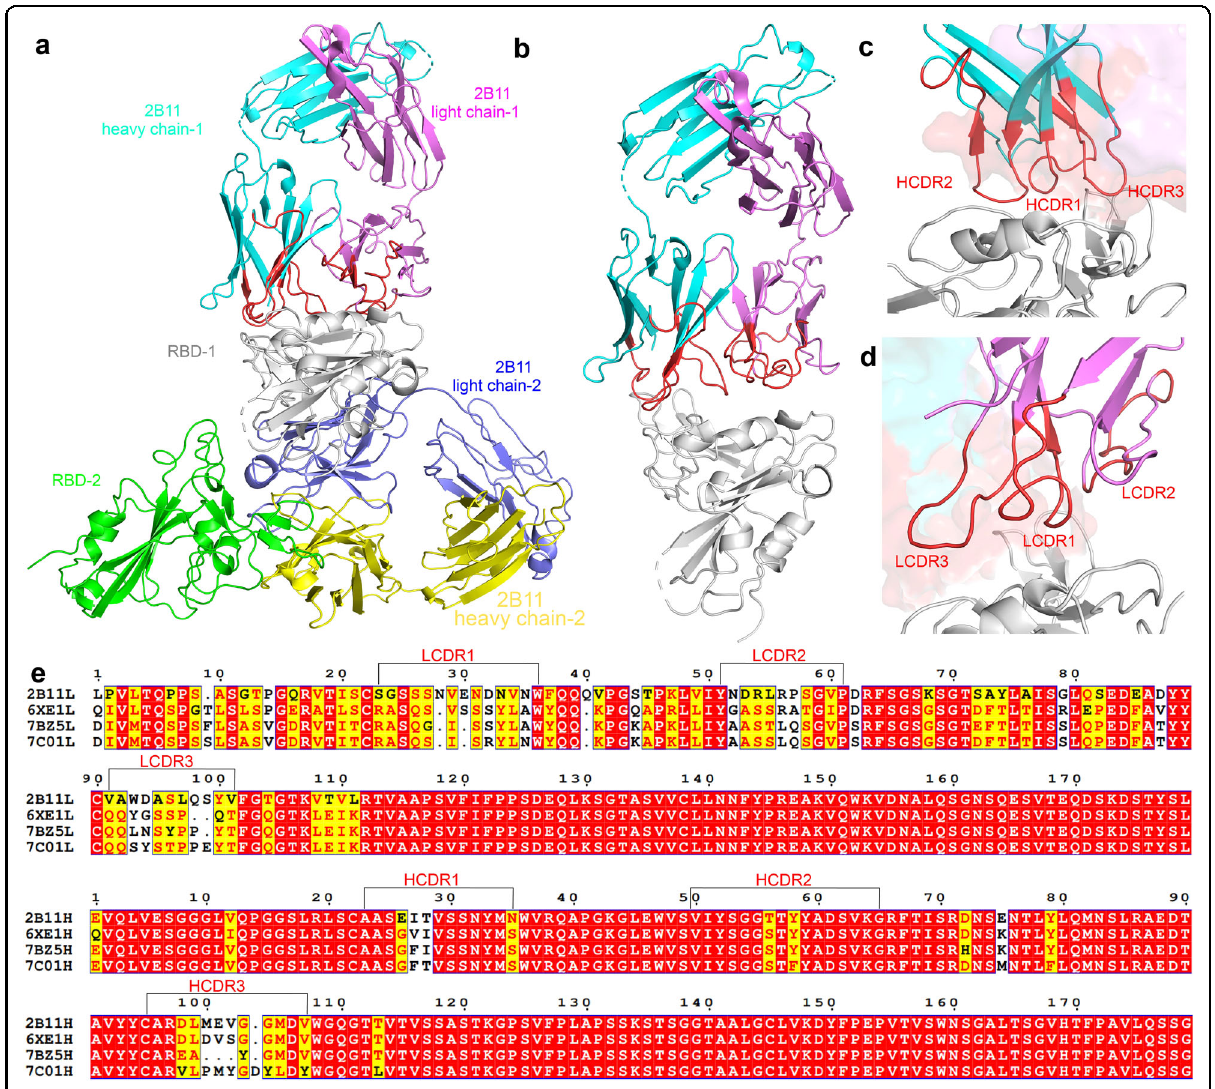
Fig. 4 Overall structure of the 2B11-Fab in complex with the SARS-CoV-2 RBD. a , b The overall structure of 2B11-Fab in complex with the SARS- CoV-2 RBD. The structure is shown as a cartoon. The 2B11 heavy chain is shown in cyan and yellow. The light chain is shown in violet and light blue. RBD is shown in gray and green. The CDRs are shown in red. c , d Details of the interactions between the 2B11 heavy (up) and light (down) chains and the RBD. The CDRs are color-coded. e Sequence alignment of the 2B11 heavy and light chains with those of reported Fab complexes. The black brackets above the sequence highlight the residues that interact with the